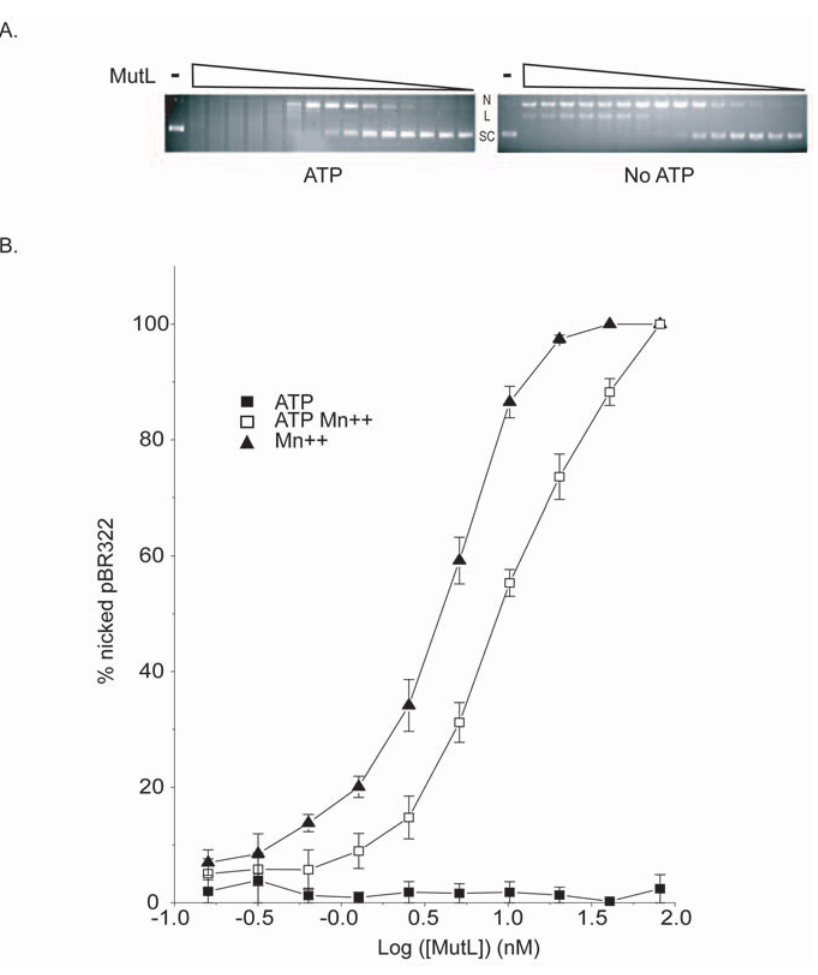
Figure 1. Endonuclease activity titration of Aae MutL. A, Representative data for the nicking of supercoiled pBR322 by various Aae MutL concentrations. The reactions were performed in the presence of 1 mM Mn ++ and with (left hand panel) or without (right hand panel) 1 mM ATP. The reaction products were resolved on a 1% agarose gel and supercoiled (SC), nicked (N), and linear (L) forms of the plasmid were visible. The control reaction (-) contained supercoiled pBR322 incubated for 1 hour at 37 u C in the absence of MutL. The reactions with 2-fold serial dilutions of MutL from 2600 nM (lane 2) to 0.159 nM (lane 16) were incubated for 1 hour at 37 u C. B, Graphical representation of agarose gel data showing the relaxation of pBR322 by different amounts of Aae MutL. The enzyme titration was performed as in Figure 1A with 1 mM Mn ++ (solid triangle), 1 mM ATP (solid square), or 1 mM Mn ++ and 1 mM ATP (open square). Each point represents the average of 3 separate experiments.